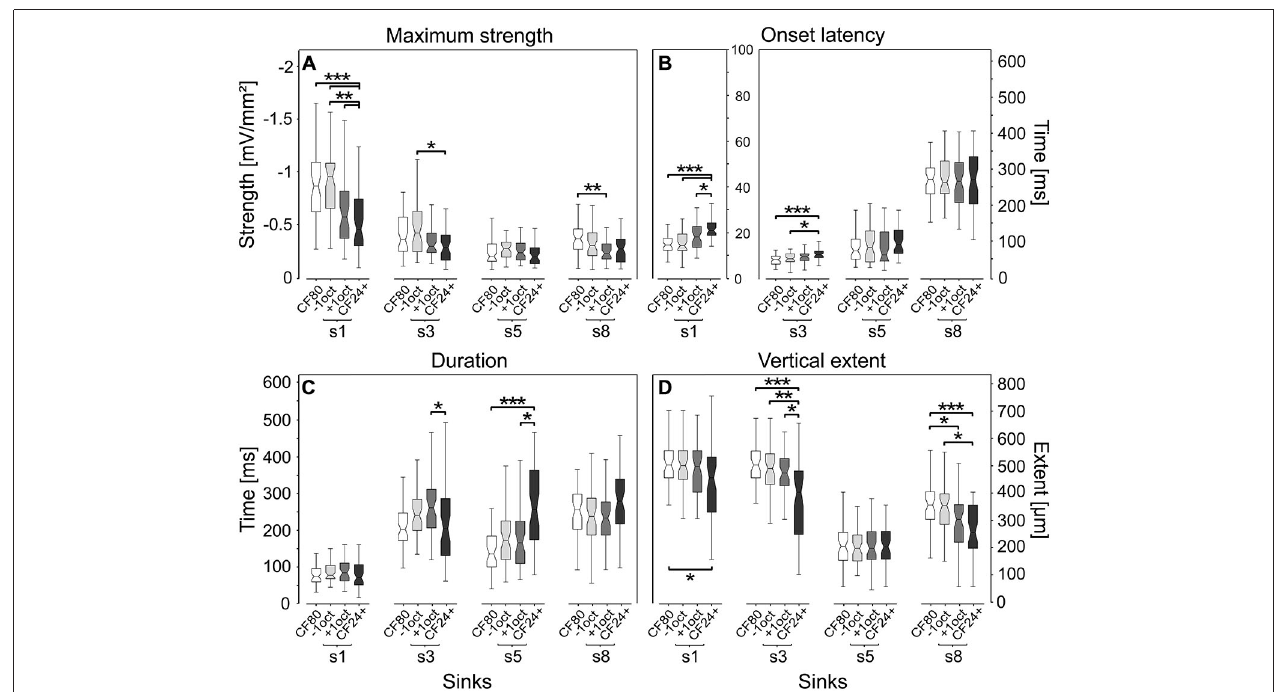
FIGURE 6 | Quantitative comparison of sink parameters. Parameters were calculated at 8% of the maximum sink strength of the respective CSD pattern elicited by CF80 stimulation. Low level pure tones (CF24+) and pure tone frequencies of one octave distant from CF ( − 1oct and +1oct) evoke significantly different sinks. Primary sink s1 (see sinks schematic above) and the most strongly elicited secondary sinks from infragranular layer VI (s3) and V (s5) and granular layer IV (s8) are compared. Four parameters were quantitatively assessed: (A) maximum sink strength, related to the strength of neuronal activity. (B) Sink onset latency, note the different y-axes for s1 vs. other sinks. (C) Sink duration. (D) Sink vertical extent. Boxplot whiskers represent data range, outer edge of box represents second and fourth quartiles of data, and midline represents median of data. Significance was determined using Kruskal-Wallis one-way ANOVA in combination with a